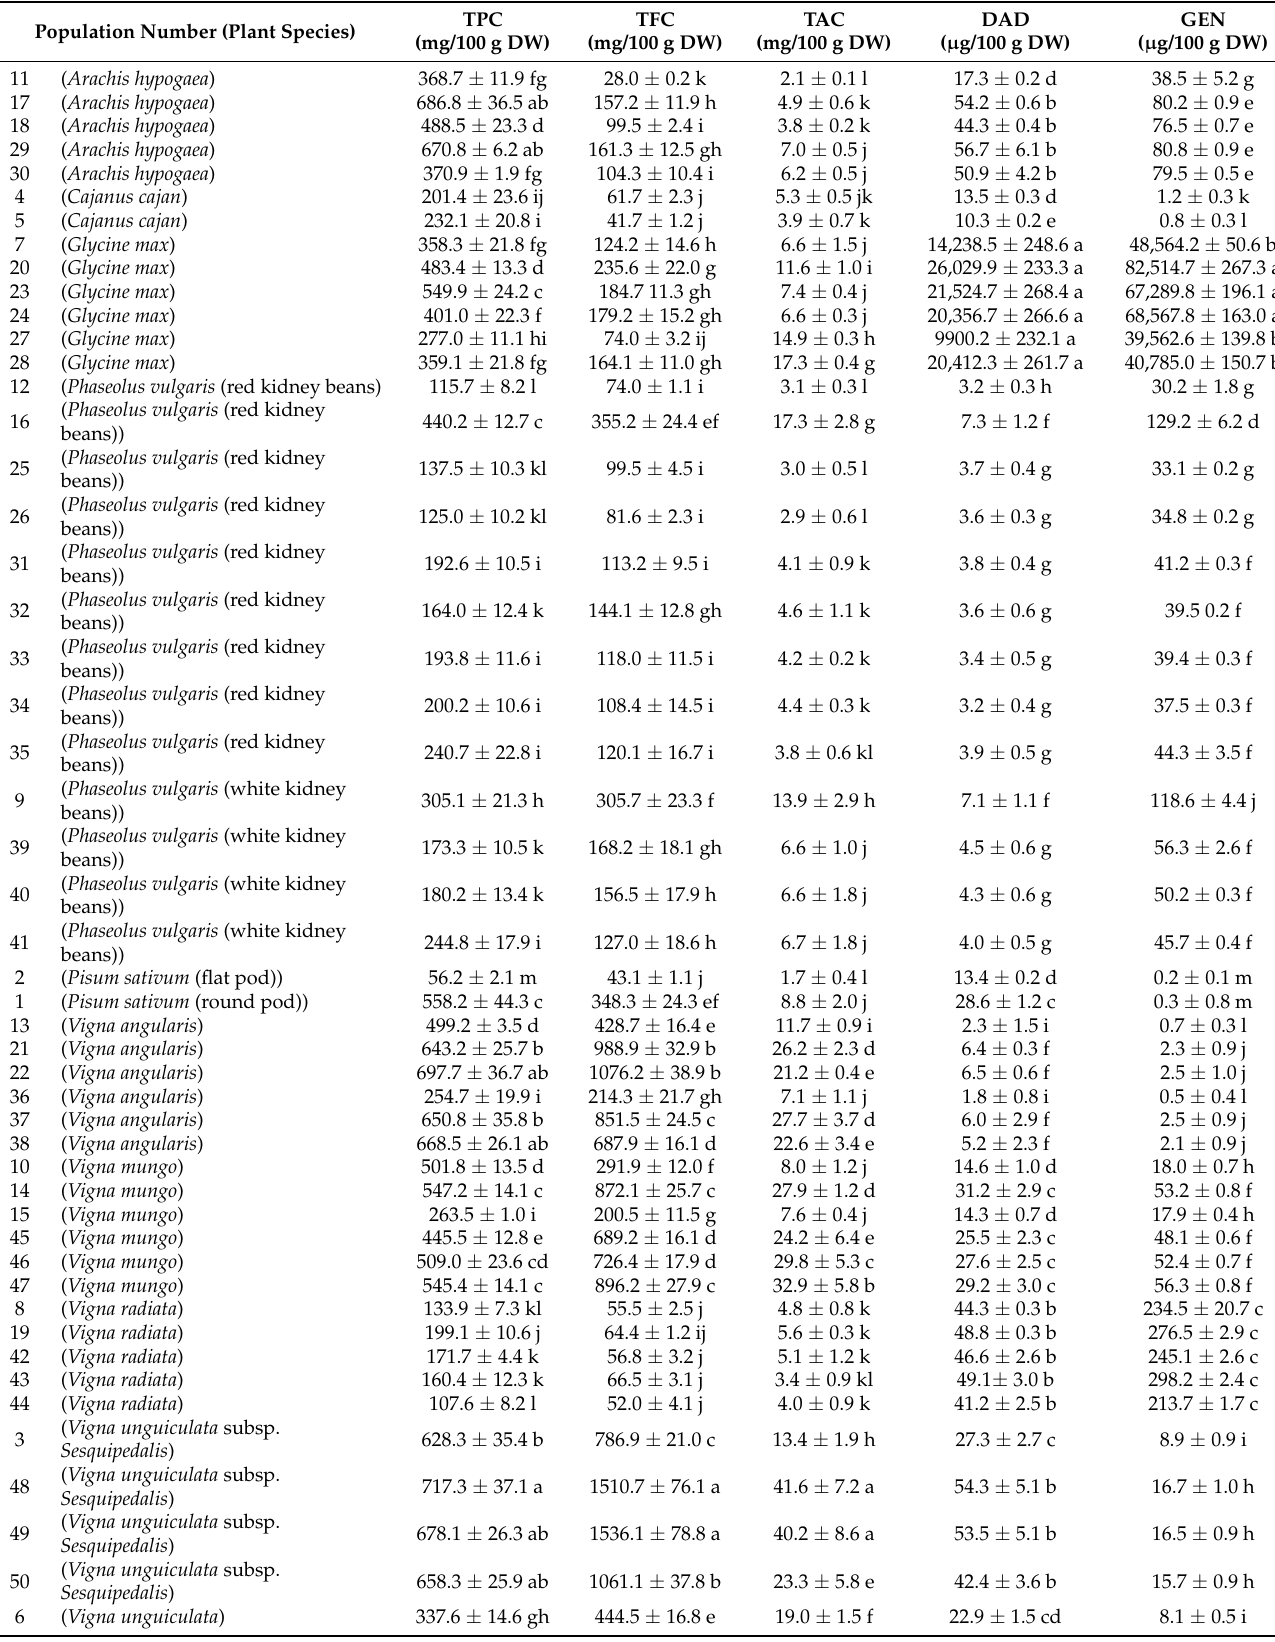
Table 2. Phytochemical profiles of 50 Fabaceae populations from various floristic regions from Thailand. Population Number (Plant